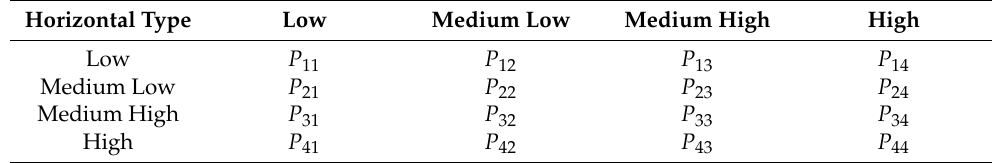
Table 2. Markov transition probability matrix ( k =